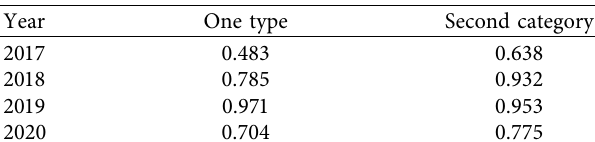
Table 1: Environmental quality of seawater in the South Atlantic